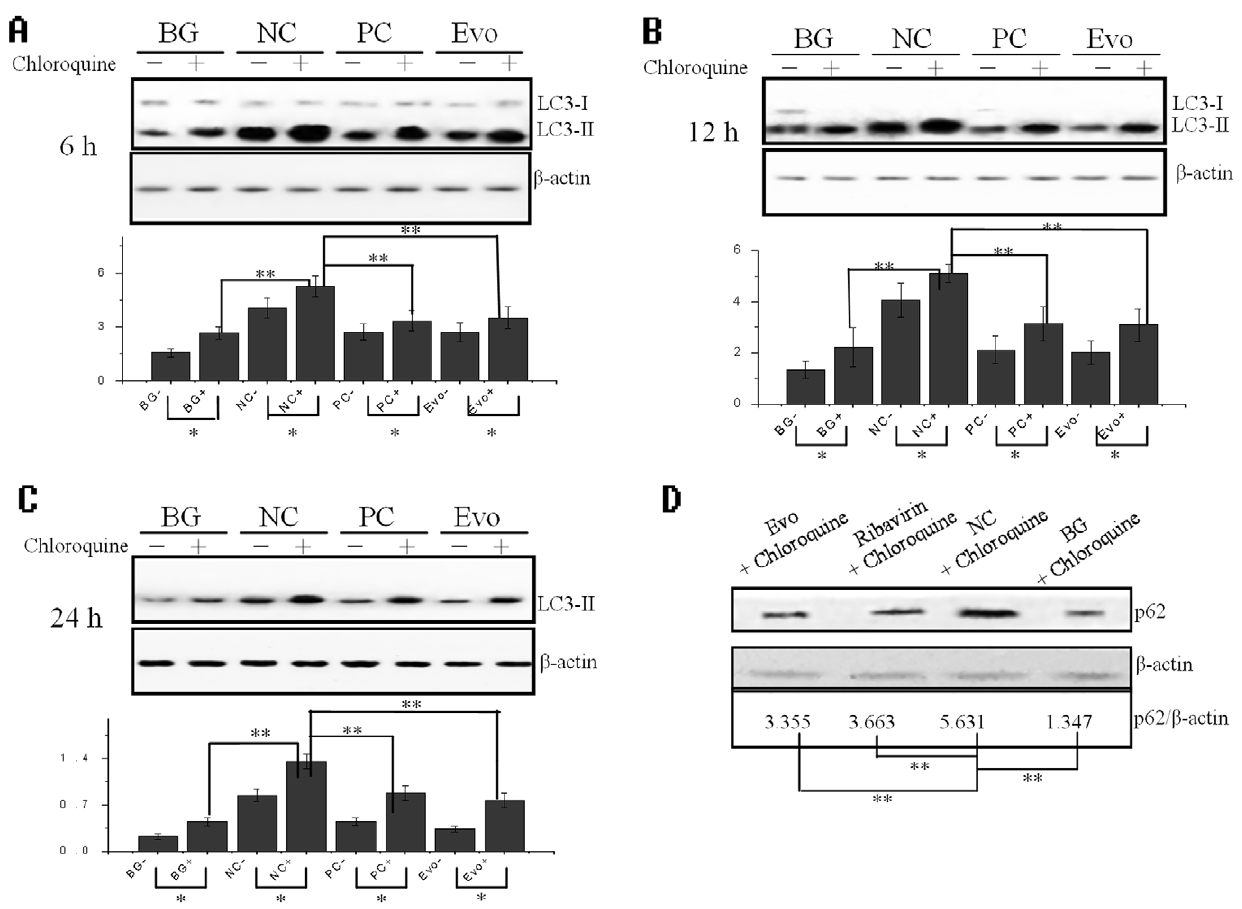
Figure 5. Evodiamine inhibits the IAV-induced autophagy determined by Western blot. ( A–C ) Inhibition of evodiamine on the ratio of LC3-II to b -actin after infection for 6, 12, and 24 h, respectively, as seen by Western blot. MOI=0.001. ( D ) Inhibition of evodiamine on the ratio of p62 to b -actin after infection for 24 h. In the BG group, the A549 cells were not infected with IAV and not treated with the drugs. In the NC group, the cells were infected with IAV but not treated with the drugs. In the PC and evodiamine (Evo) groups, A549 cells were infected with IAV and treated with ribavirin (25 m g/mL) and evodiamine (12.5 m g/mL), respectively. MOI=0.001. The total gray value of each band was determined using a Gel-Pro analyzer 6.0. The ratio of LC3-II or p62 to b -actin is presented below. Data shown were the mean 6 SD of three independent experiments. * P , 0.05, ** P , 0.01.